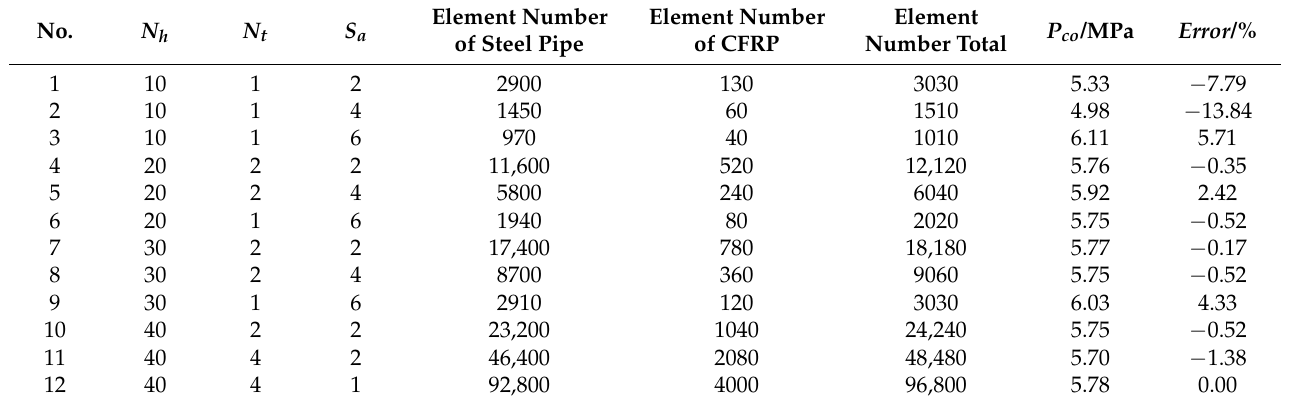
Table 4. Mesh convergence